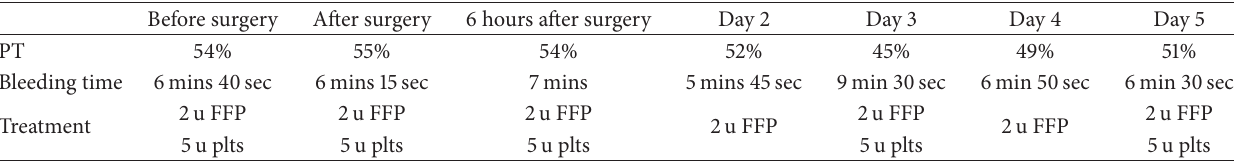
Table 1: Results of daily blood tests and